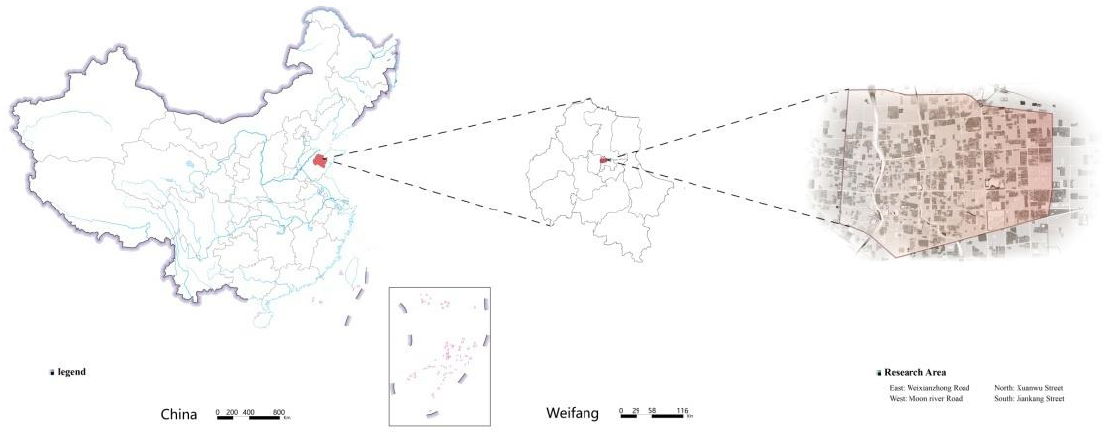
Figure 3. The geographical location of Weifang in China (Source: Authors’ own drawing).